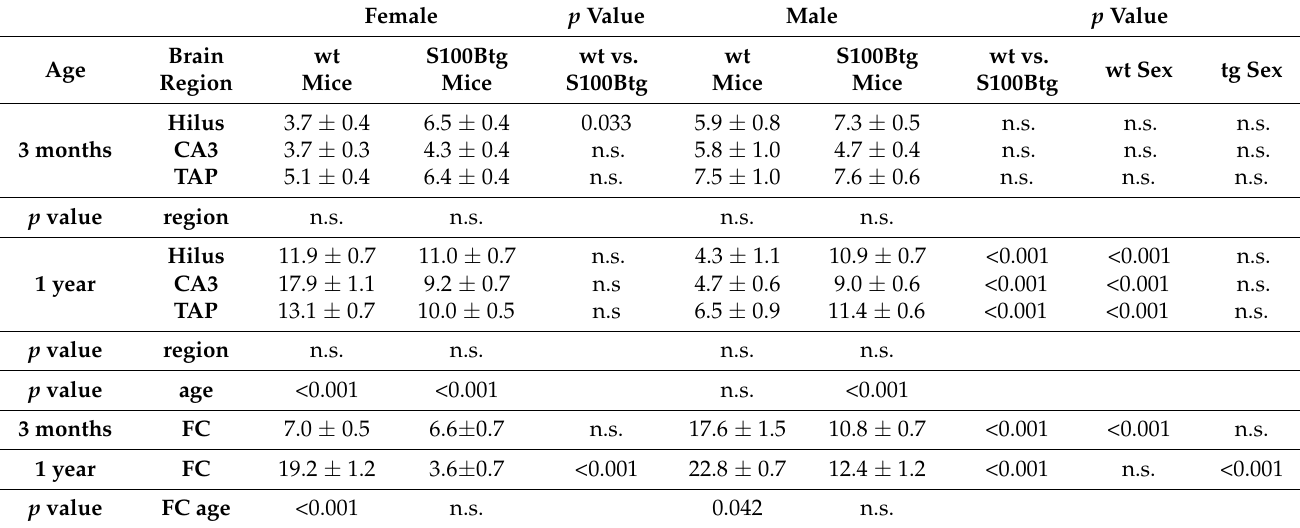
Table 1. Quantification of relative ThT fluorescence. In different hippocampal pathways (hilus: dynamic regulation of pattern separation; CA3 region: termination of entorhinal cortex layer 2, novelty detection and short-term memory; temporoammonic pathway TAP , monosynaptic projection from entorhinal cortex layer 3 to the CA1 region, involved in spatial memory learning) and in the frontal cortex (FC) in three-month- and one-year-old wt and S100Btg mice. n.s. non significant. Female p Value